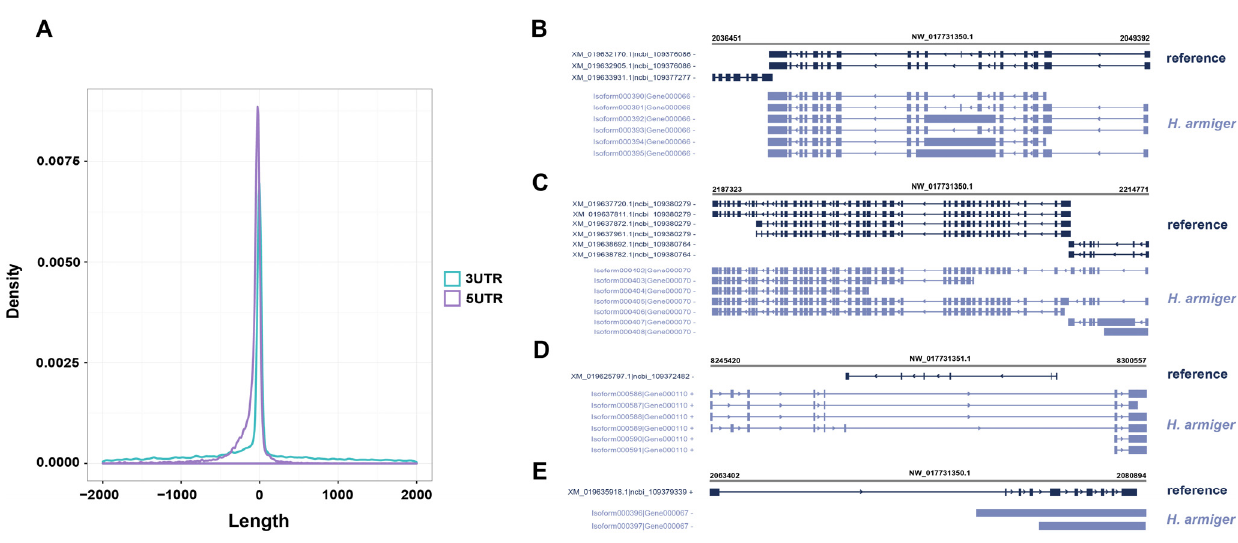
Figure 10. Optimization of H. armiger gene structure. ( A ) UTR length variation frequency distribution. ( B , C ) Isoforms spanning two or more reference genes. ( D ) An example classified as intron isoforms. ( E ) An example classified as Exonic overlap isoforms.